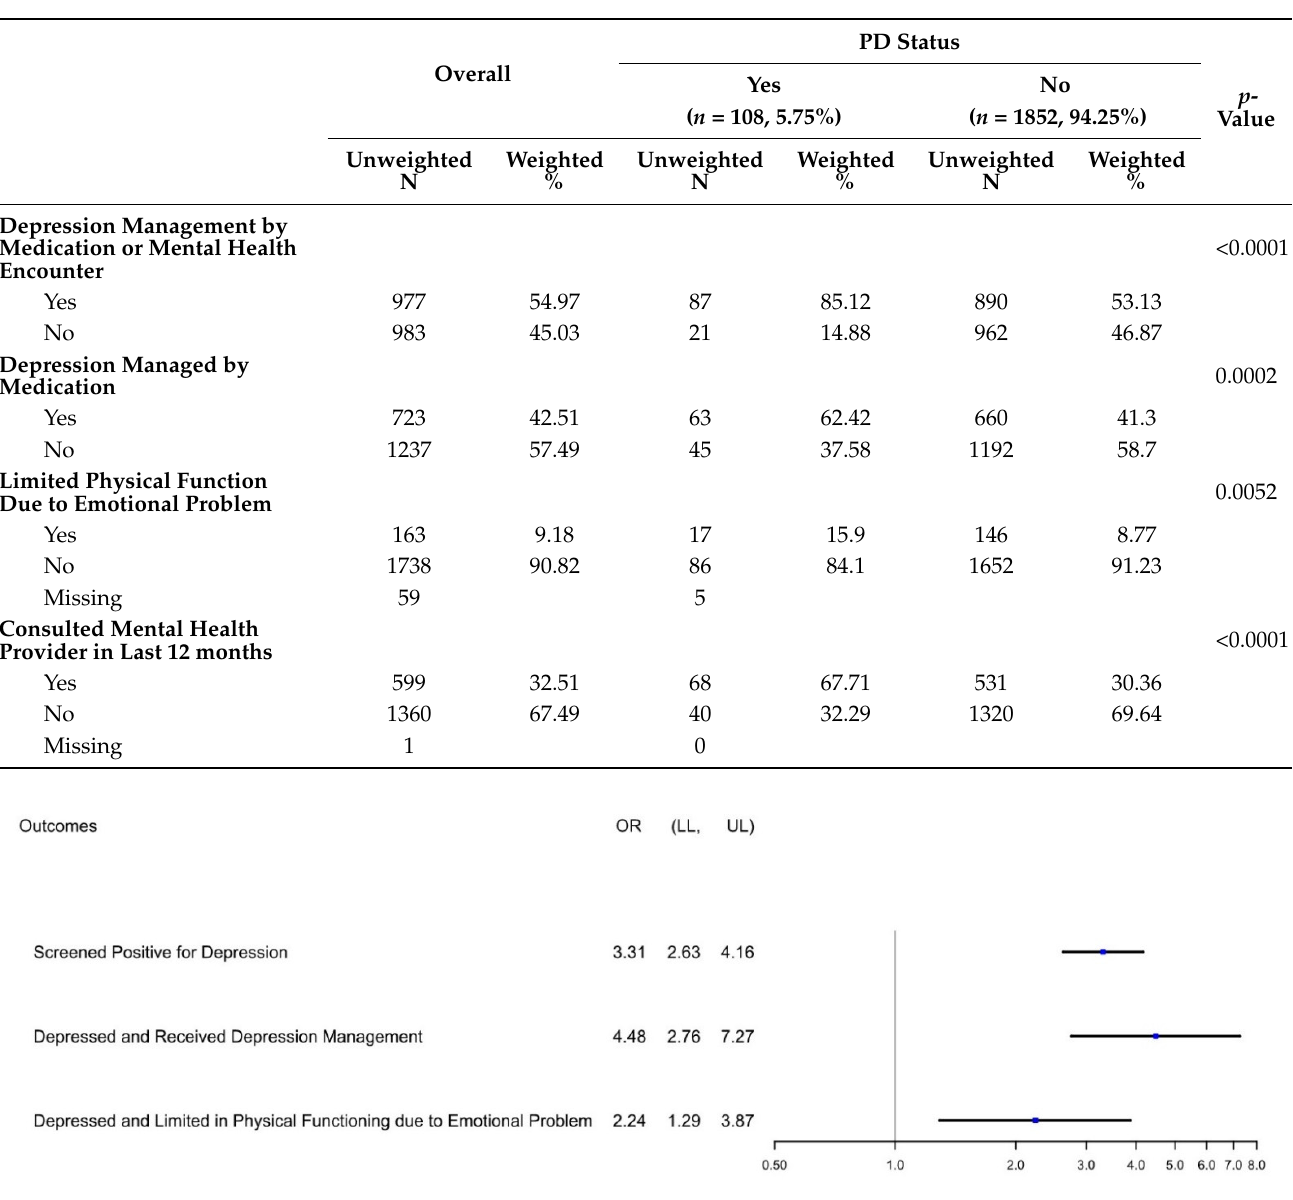
Figure 2. Forest Plot of Odds Ratio (OR) by PD Status. Among the entire population, OR was calculated for positive depression screen based on use of anti-parkinsonian medication. Among the portion of the population screening positive for depression (PHQ-9 ≥ 10), OR was calculated for receipt of any depression management (pharmacologic or consultation with mental health provider) and limitation of physical functioning due to depression, anxiety, or another emotional problem. LL: Lower Limit of 95% Confidence Interval. UL: Upper Limit of 95% Confidence Interval.